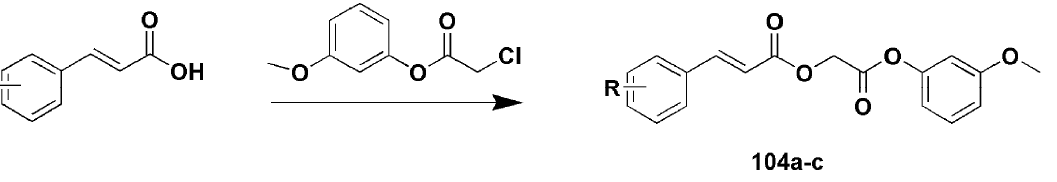
Figure 28. Chemical structures of compounds 46 , 64 , 65 , 100 – 103 [73].